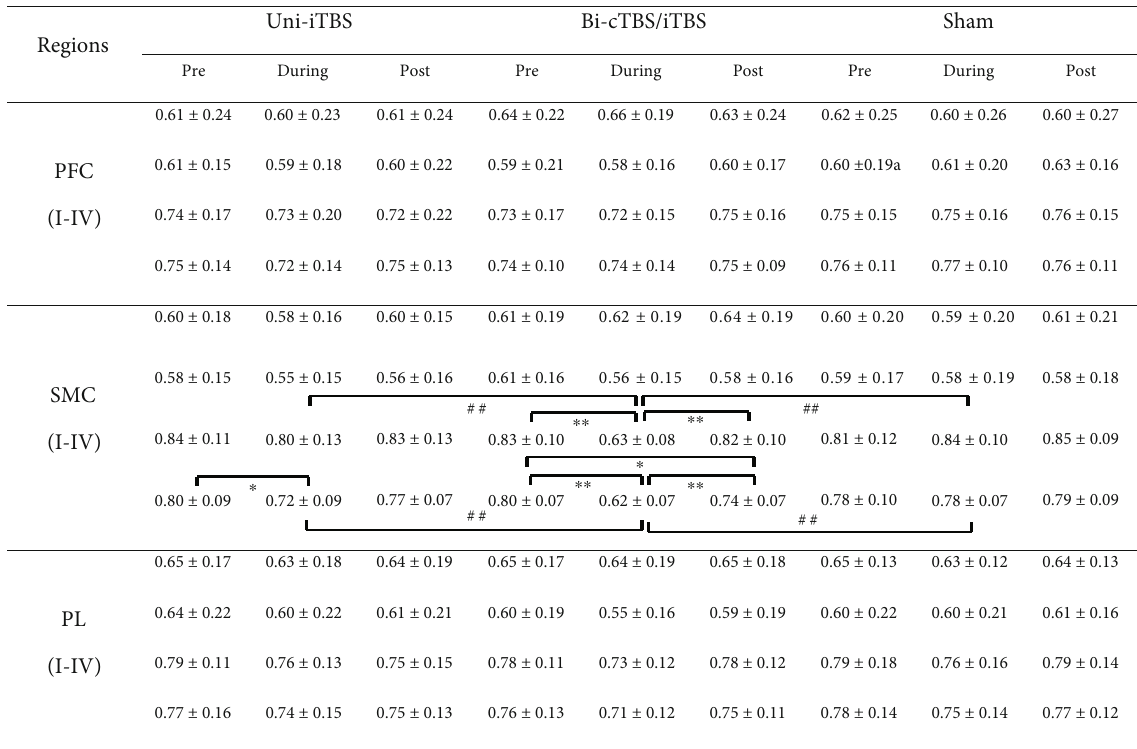
Figure 5: IHCCs in di ff erent cortical regions under three HD-TBS protocols. Data: untransformed IHCC mean ± SEM ; bands I – IV: 0.7 – 2.0Hz, 0.15 – 0.7Hz, 0.06 – 0.15Hz, and 0.02 – 0.06Hz, respectively. ∗ p ≤ 0 : 05 and ∗∗ p ≤ 0 : 01 for signi fi cance among three phases. # p ≤ 0 : 05 and ## p ≤ 0 : 01 for signi fi cance among three HD-TBS